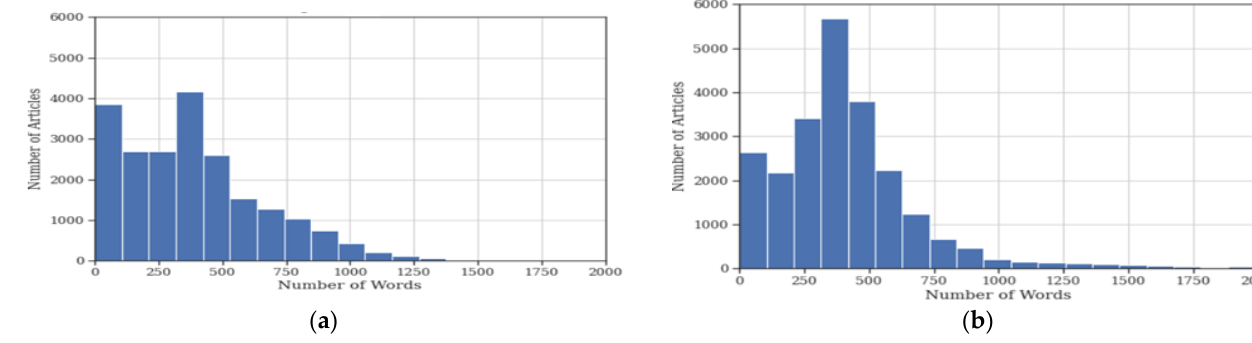
Figure 9. The number of words and articles for real and fake news; ( a ) real news word counts vs. several articles; ( b ) fake news word counts vs. several words.